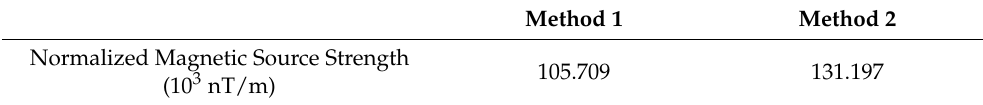
Table 6. Root mean square error between inversion results and measured data under different